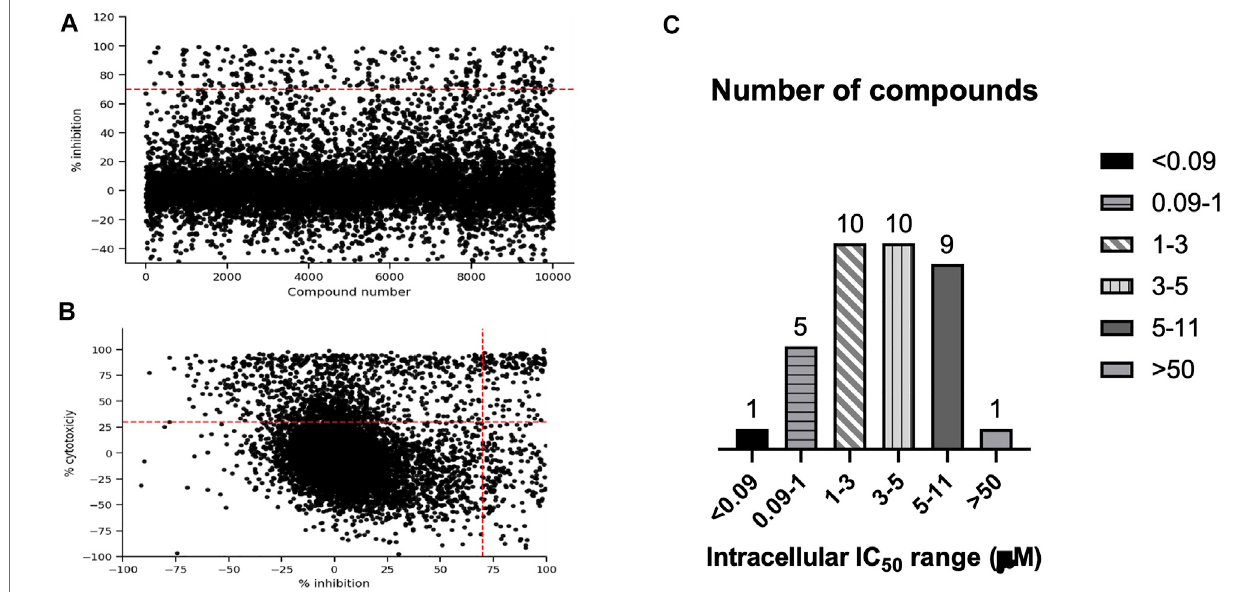
FIGURE 2 | High content, high throughput screen against intracellular M. tuberculosis . (A). Compounds were tested for activity against RAW264.7 cells infected with M. tuberculosis at an MOI of 1. The primary screen was conducted using a single concentration of each molecule at 10 1.1 M. Inhibition of bacterial growth and macrophageviabilityweredeterminedforeachcompoundafter72 h (A) .Anti-tubercularactivitymeasuredas%inhibitionofbacterialgrowth. (B) Cytotoxicity(%viability) was plotted compared to inhibition of bacterial growth (% Inhibition). Compounds in the top right quadrant were eliminated from the hit list due to cytotoxicity. (C) Selected hit compounds were purchased and tested in dose response to determine IC50 (concentration required to inhibit bacterial growth by 50%). Number of compounds in each group are